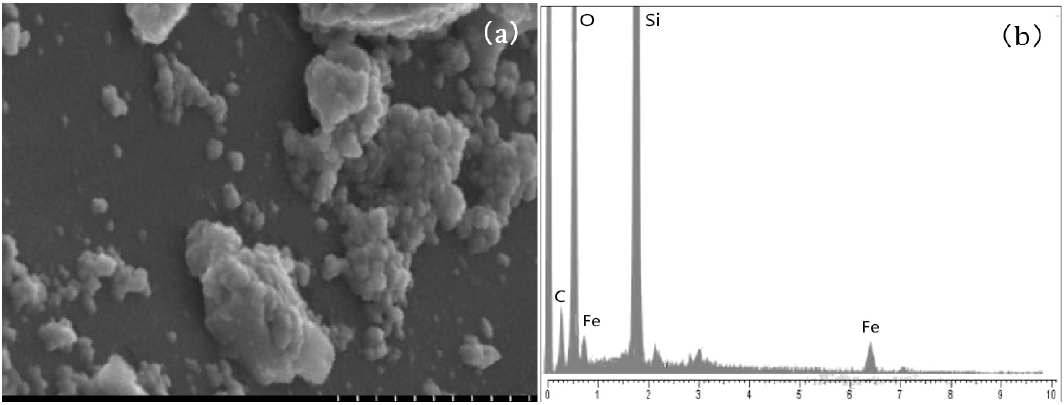
Figure 1. Scanning electron microscopy ( a ) and energy-dispersive X-ray analysis ( b ) of hematite-coated sand.